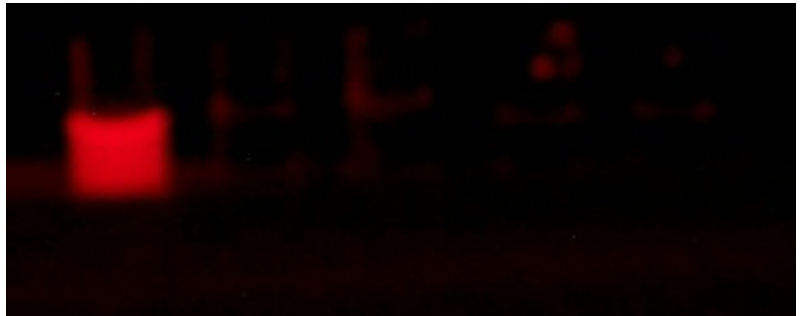
FIGURE 4. Luminescence photo of samples of Fig.